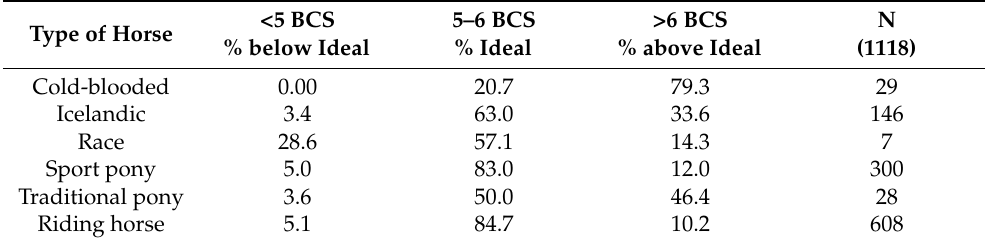
Table 6. Distribution of below ideal, ideal, and above ideal BCS in relation to the type of horse. <5 Type of Horse